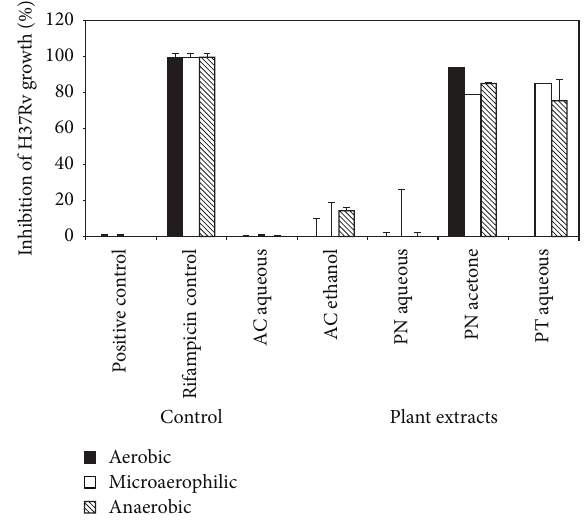
Figure 3: Activity of plant extracts under reducing oxygen con- centration against H37Rv. The 5 intracellularly active plant extracts were tested on H37Rv under reducing oxygen concentration. Viable M.tb acted as the positive control whereas rifampicin was used as the experimental control. P. nigrum acetone extracts showed inhibition of bacterial growth under all 3 conditions. The results are represented as mean ± SD of three